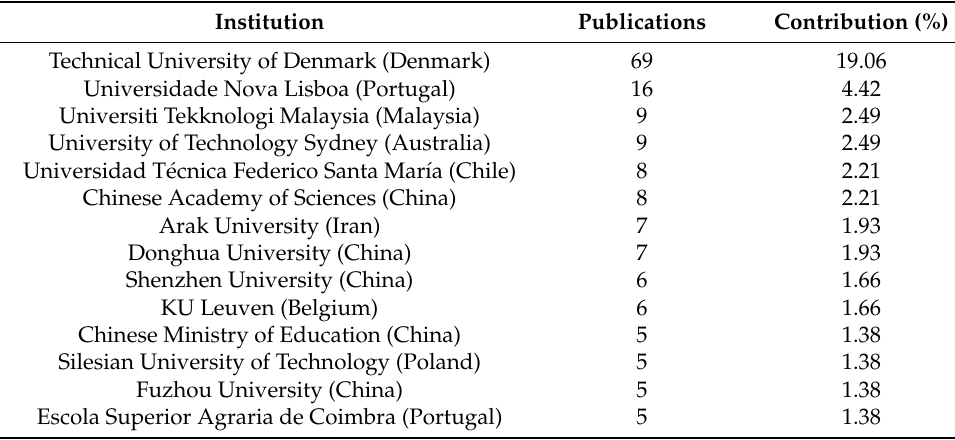
Table 4. The top 14 most productive institutions (at least 5